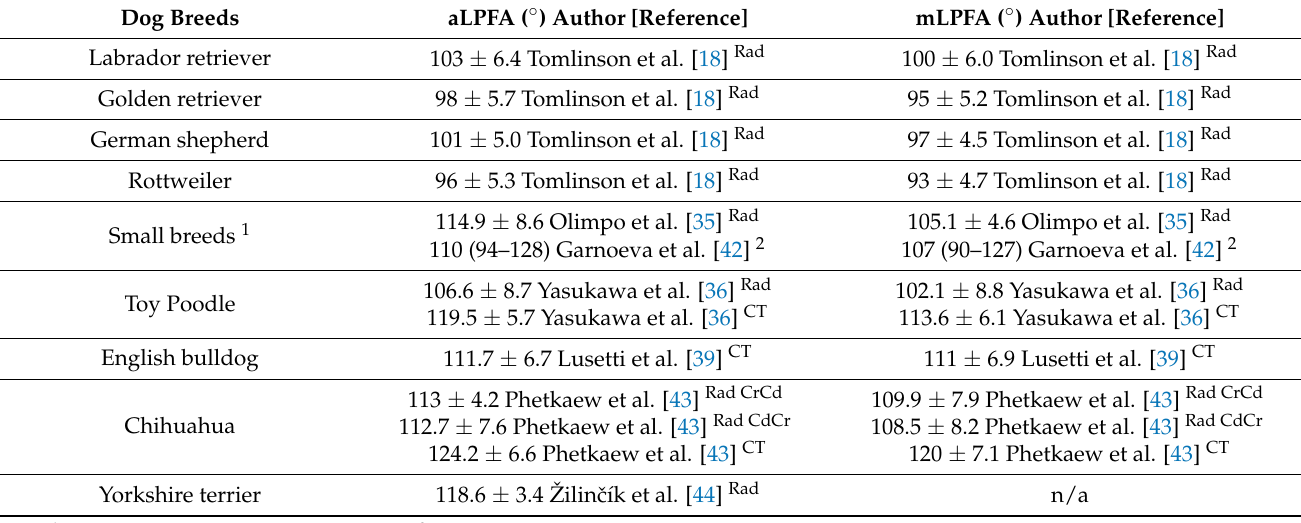
Table 6. Mean ± standard deviation of anatomical lateral proximal femoral angle and mechanical lateral proximal femoral angle in healthy